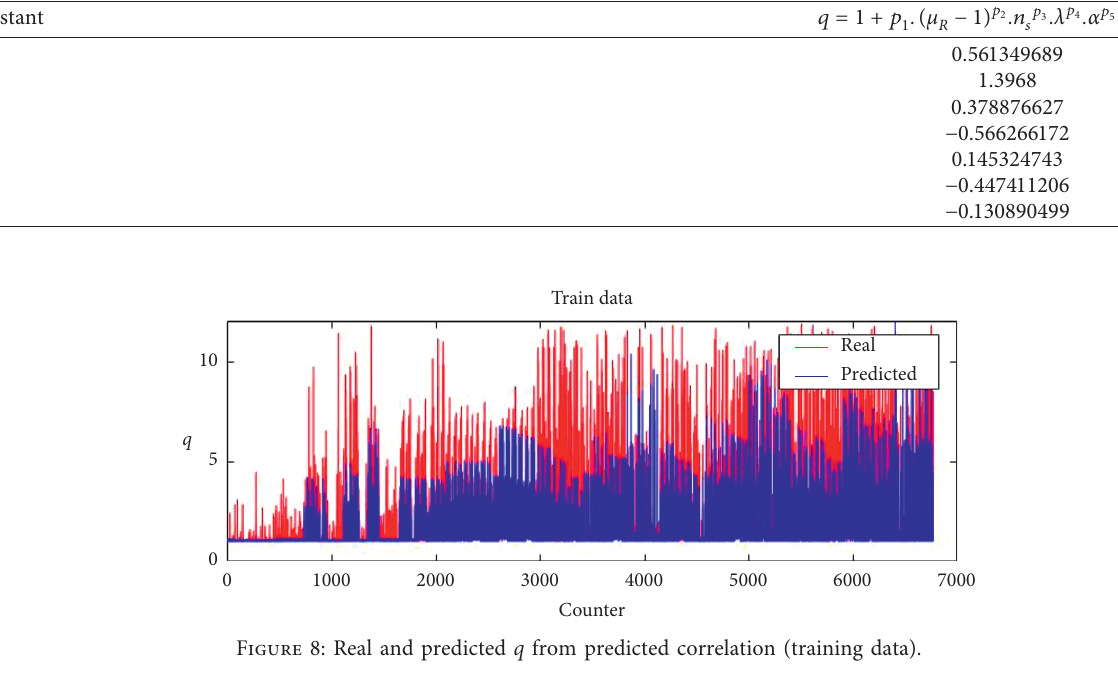
Table 5: The final proposed correlation and its constants.